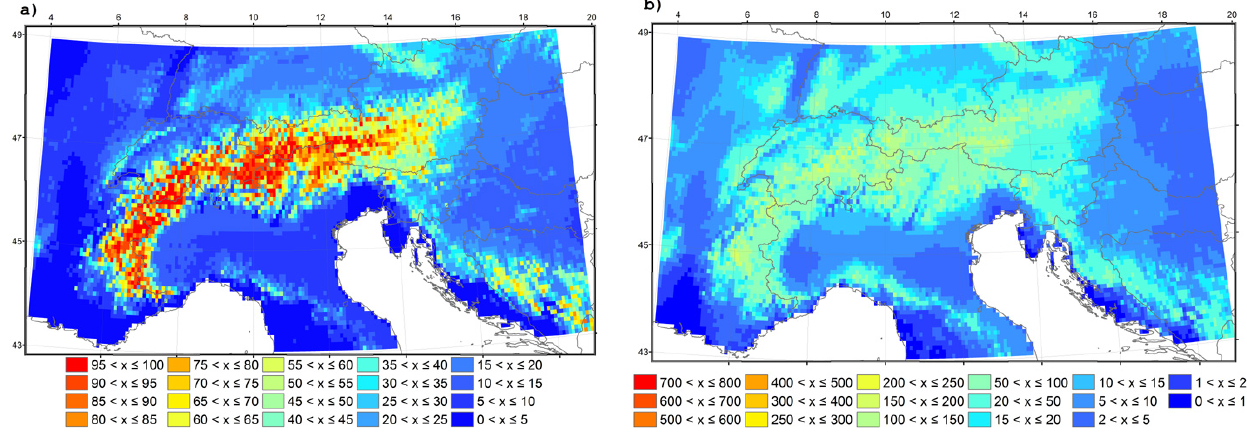
Figure 2. Percentage [%] (a) and amount [mm water equivalent] (b) of solid precipitation in the GAR for December 1929. Red / blue colours representing high / low